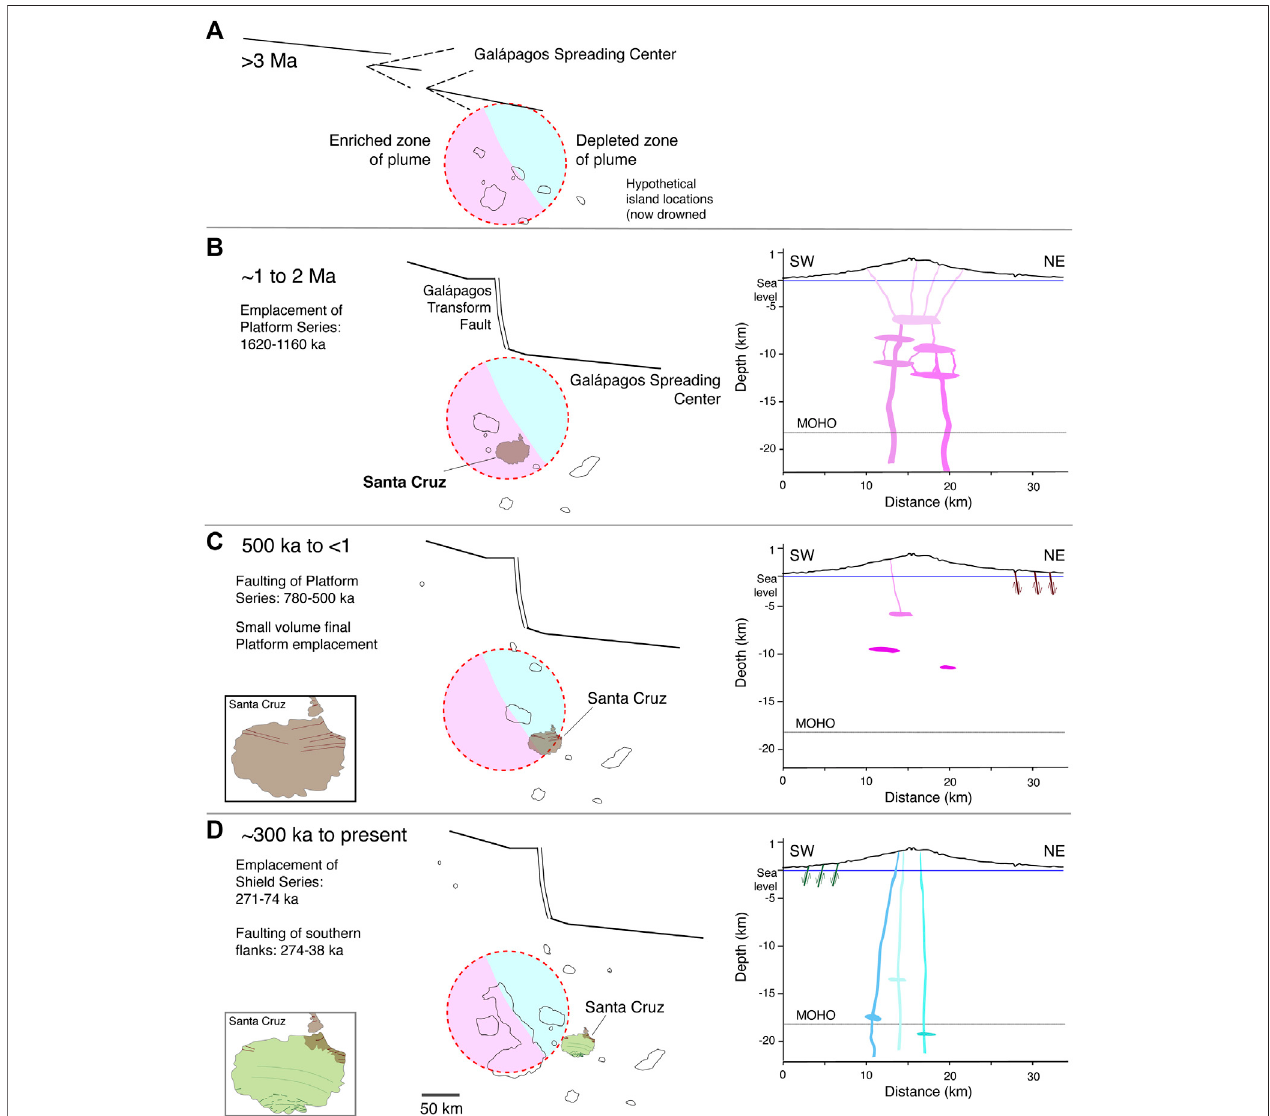
FIGURE 11 | A conceptual timeline of Santa Cruz ’ s volcanic evolution. Left side panels: Map view of archipelago and relationship between plume, islands, and GSC. Right side panels: NE-SW cross-section of Santa Cruz. Note that vertical scales above and below 0 km are different, and that island cross-section has a vertical exaggeration of4×. Current depth totheMOHO isestimated at ~17 km(Feighner and Richards, 1994). (A) LEFT: Prior to~3 Ma, the GSC wasnearly superimposed on the Galápagos plume (Wilson and Hey, 1995). None of the present-day Galápagos Islands date to 3.5 Ma (White et al., 1993), but older islands now submerged downstreamtotheeastexistedatthetime;theirlocationsarehypothesizedhere(Christieetal.,1992).Theplume ’ s(reddashedcircle;limitsestimatedfromGibsonetal., 2012) bilateral compositional asymmetry is indicated with the pink (more enriched, LLSVP-sourced) and blue (more depleted, lower mantle-sourced) zones (Harpp and Weis,2020).EvolutionoftheGSCisbasedonMittelstaedtetal.(2012). (B) LEFT:At~2 Ma,SantaCruzbeginstoformandemerge;between1629and1160 ka,mostof the Platform Series lavas sampled in this study are emplaced (brown; Schwartz et al., 2022). The Platform Series is being emplaced as Santa Cruz approaches the compositional boundary of the plume, resulting in geochemical signatures slightly less enriched than present-day Fernandina lavas. According to Mittelstaedt et al. (2012), the Galápagos Transform Fault is formed in the most recent southward jump of the GSC ~1 Ma. RIGHT: The Platform Series lavas constitute the main shield- building phase of Santa Cruz. The proximity of the GSC causes diversion of some plume material toward the ridge, resulting in lower fl ux to the nascent Santa Cruz volcanothancurrentlysuppliesFernandina,suf fi cienttosupportformationofamagmaticnetworkcapableofpartiallyhomogenizingmeltspriortoeruption,butunableto generate thermochemically buffered conditions. (C) LEFT: Between 780 and 500 ka, the Platform Series experiences normal faulting, likely in response to the ~1 Ma southward jump of the GSC. Faults are shown in crimson on the north side ofSanta Cruz and Baltra ( see inset; possible extensions ofthe faults toward the center of the island are shown as dashes). RIGHT: Normal faulting from Galápagos Transform Fault-related stresses may initiate additional, small volume eruptive activity. (D) LEFT: The Shield Series (green) is emplaced between 271 and 74 ka, primarily from aligned vents that cross the volcano ’ s central highlands (green dashed lines). Nearly contemporaneously,normalfaulting(dark greenlines)occursalongthesouthern fl ankoftheisland(274 – 38 ka; see inset;Schwartzet al.,2022). RIGHT: Southern fl ank of Santa Cruz begins to slump, forming extensional structures. Magma in small, ephemeral, poorly networked reservoirs that are incapable of storing or homogenizing melts is erupted as the Shield Series, with more variable and more primitive compositions compared to the Platform Series. The island has crossed into the plume ’ s eastern compositional zone, causing lavas to have more depleted geochemical signatures (blue colors).